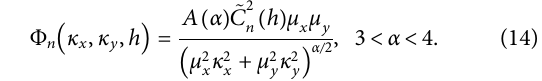
Frontiers in Physics |